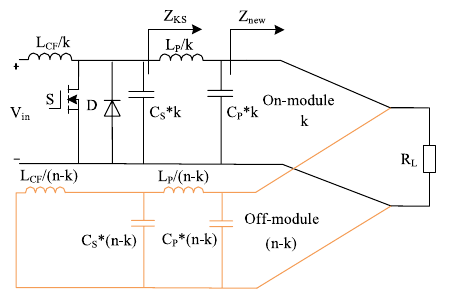
Fig. 7 Equivalent circuit when k is small